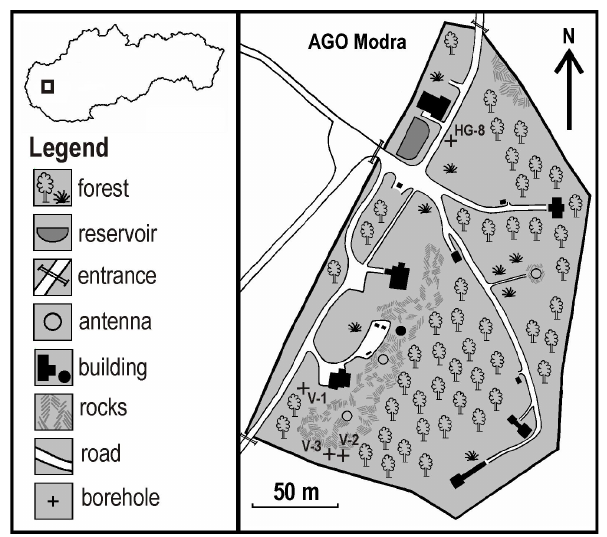
Fig. 1. Map of a sampling site with location of boreholes.